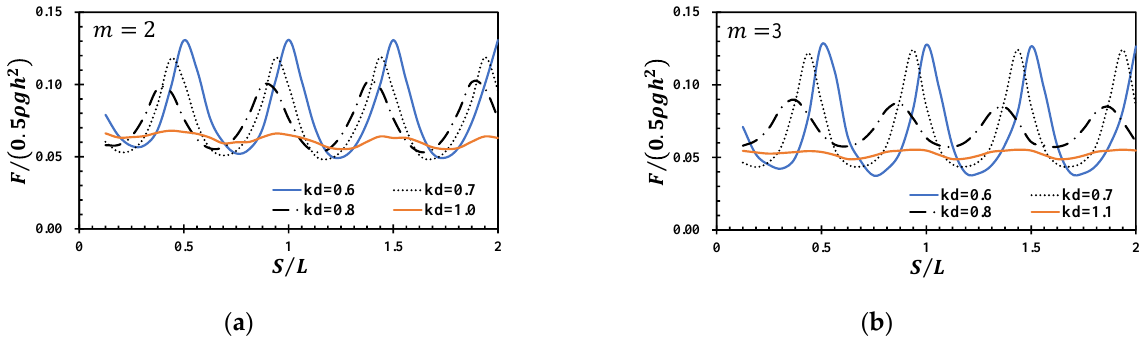
Figure 14. Variation of the pressure drag acting on the rigid breakwater with S / L for the different wave periods 𝑘𝑑 . ( a ) 𝑚 = 2 . ( b ) 𝑚 = 3 .